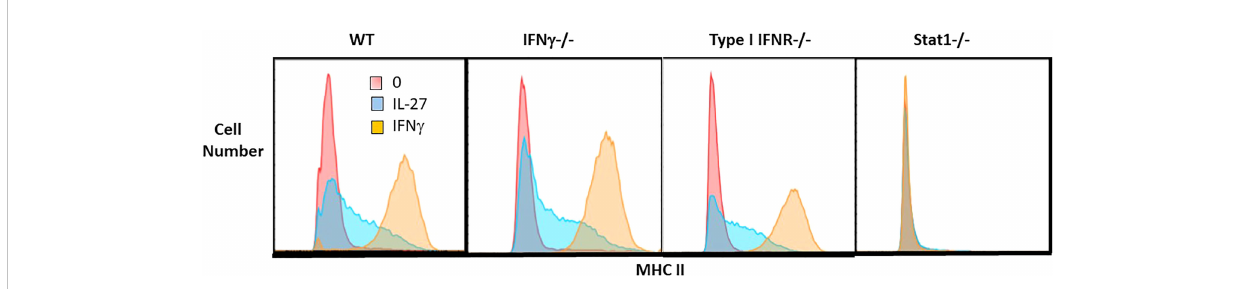
FIGURE 4 IL-27 induction of MHC II expression is independent of IFN g or type I IFNR but dependent on Stat1. Single cell suspensions of macrophages from WT, IFN g -/-, type I IFNR-/- or STAT1-/- mice were cultured for 48hr with IL-27 (100ng/ml) or IFN g (10ng/ml) or control medium alone. Following culture, macrophages were detached with trypsin/EDTA and scraping. Non-speci fi c Fc binding was blocked with anti-CD16/32, then cells were stained with rat anti-mouse I-A/I-E PE or PE rat IgG2b,k isotype control antibody (not shown). Cells were washed, fi xed and analyzed by fl ow cytometry using FlowJo